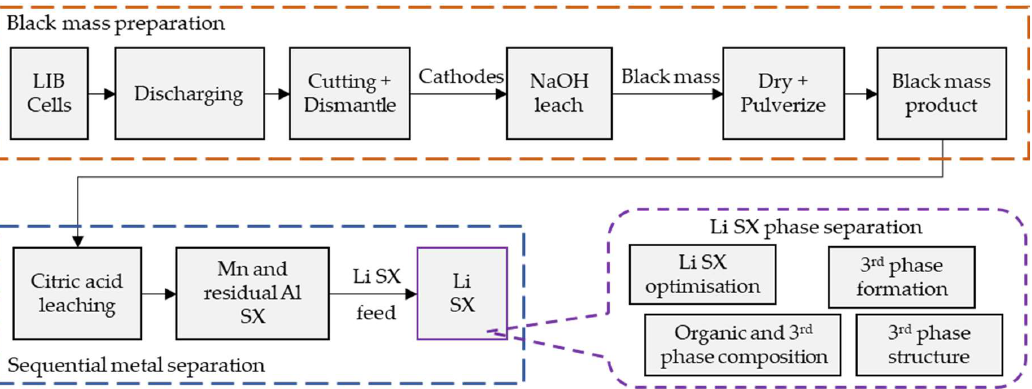
Figure 4. Block flow diagram for the Li solvent extraction from citrate media summarizing the black mass preparation by Punt et al. [9] (orange striped box) and the sequential metal separation by Punt et al. [41] (blue striped box).